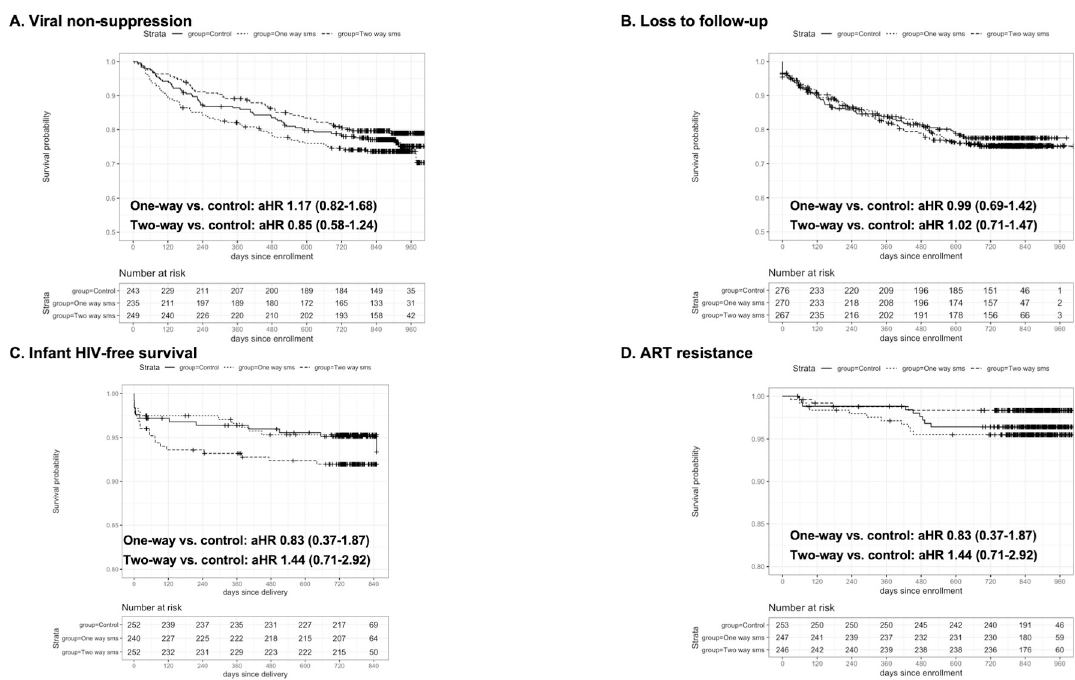
Fig 2. Effect of Mobile WACh-X on viral nonsuppression, loss to follow-up, infant HIV-free survival, and ART resistance. aHR, adjusted hazard ratio; ART, antiretroviral therapy; SMS, short message